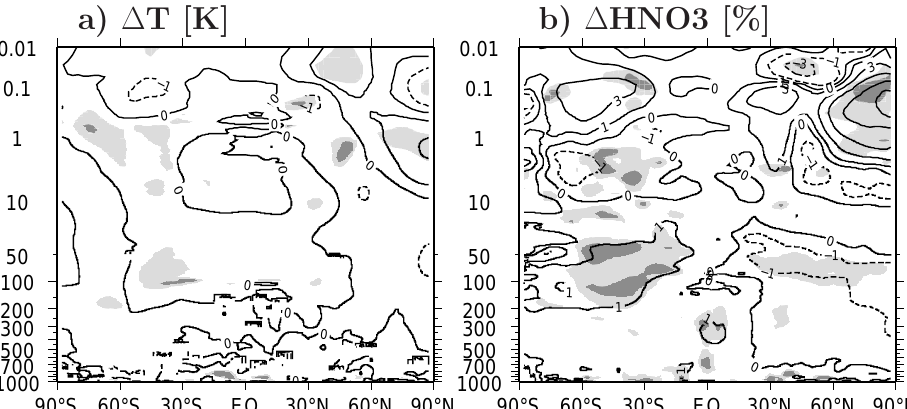
Fig. 9. Same as Fig. 6, but for the deviation of simulation coup psc versus decoup full (see Table 1). (a) 1T [K], (b) 1 HNO 3 [%] (sum of gaseous, liquid,